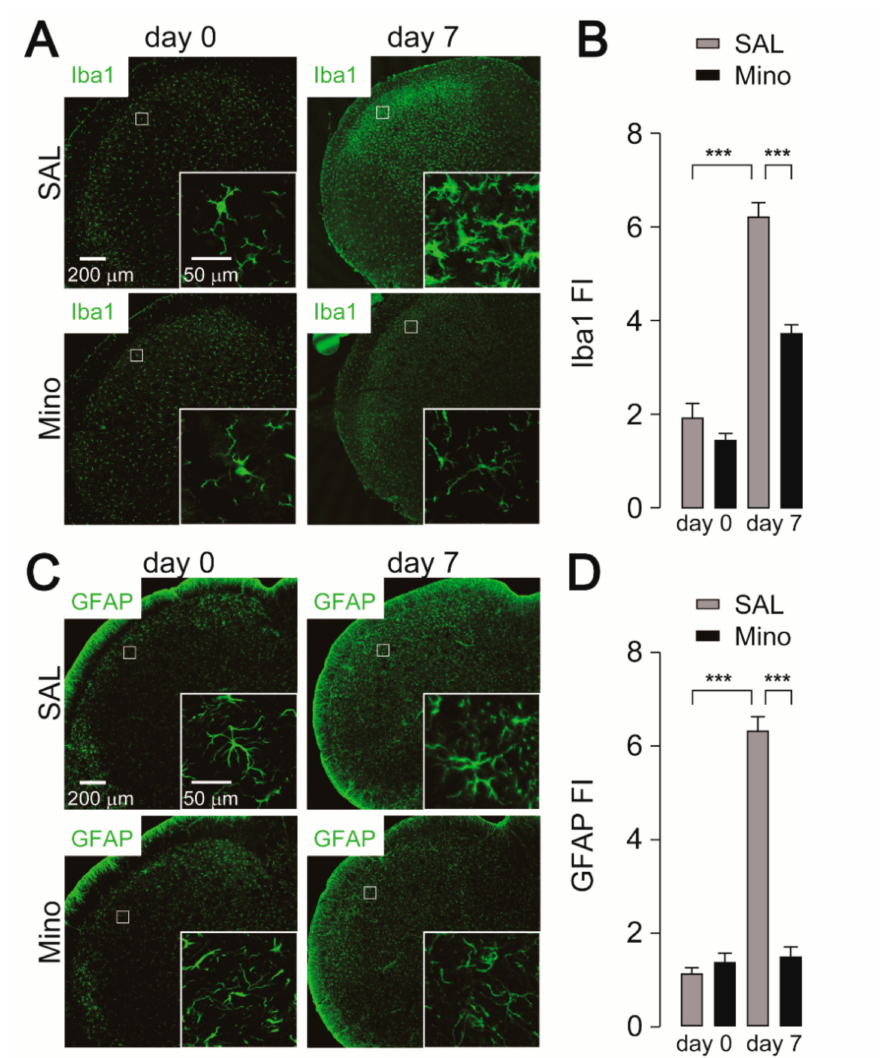
Figure 2. Inhibitory e ff ects of minocycline on cellular activation of microglia and astrocytes in the Vc following IONI. ( A ) Representative images of Iba1 immunofluorescence in the Vc. Insets indicate enlarged images of the region indicated in the open square. ( B ) Fluorescence intensity (FI) of Iba1 in the Vc of saline or minocycline-treated rats 0 and 7 days after IONI. SAL (day 0): n = 5, Mino (day 0): n = 5, SAL (day 7): n = 7, Mino (day 7): n = 10, two-way ANOVA followed by Tukey’s multiple comparison test, *** p < 0.001. ( C ) Representative images of glial fibrillary acidic protein (GFAP) immunofluorescence in the Vc. Insets indicate enlarged images of the region indicated in the open square. ( D ) Fluorescence intensity (FI) of Iba1 in the Vc of saline or minocycline-treated rats 0 and 7 days after IONI. SAL (day 0): n = 5, Mino (day 0): n = 5, SAL (day 7): n = 7, Mino (day 7): n = 10, two-way ANOVA Tukey’s multiple comparison test, *** p < 0.001. The data represent the means ±